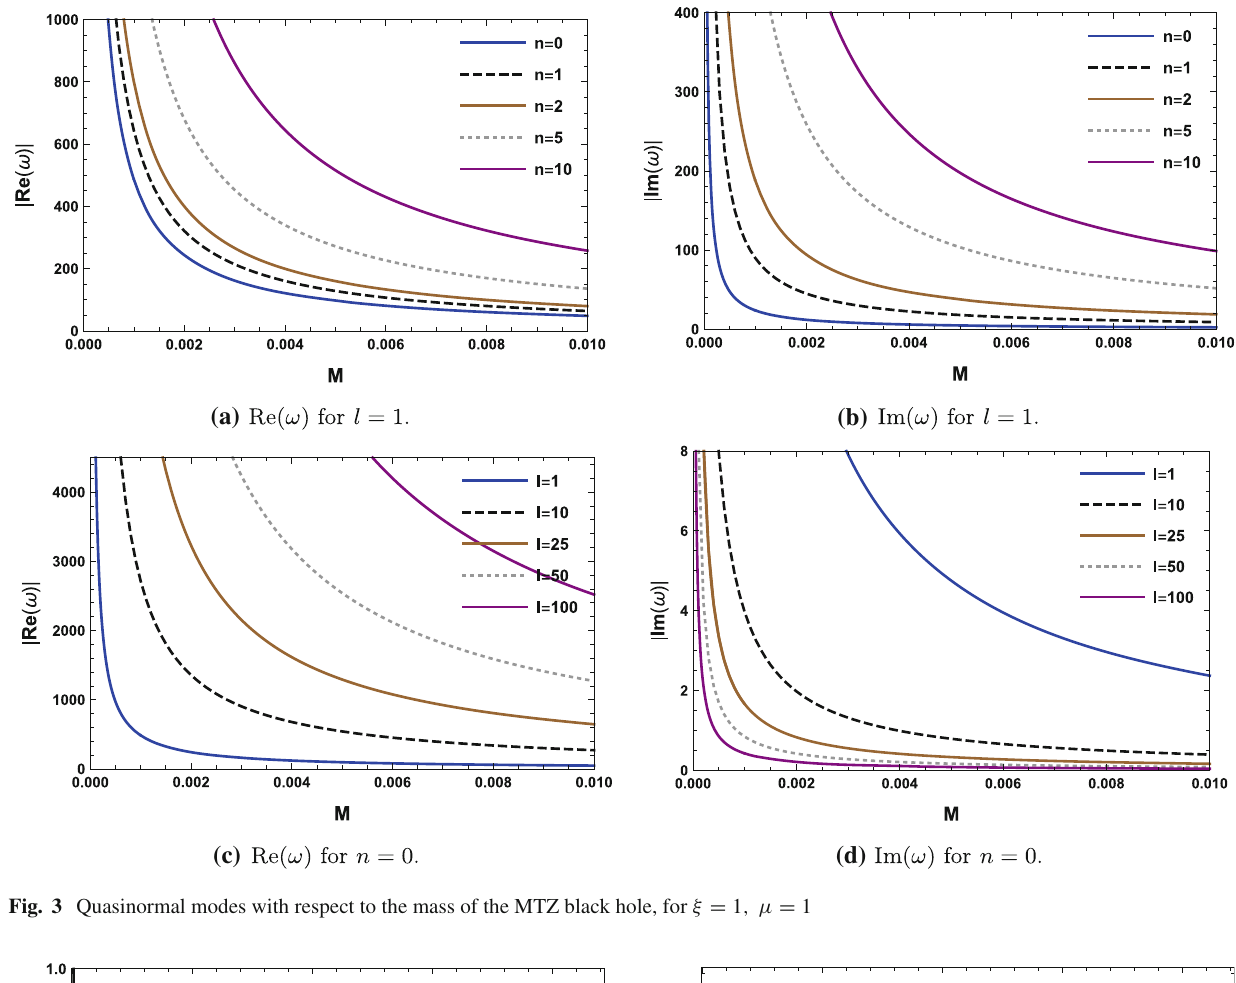
Fig. 3 Quasinormal modes with respect to the mass of the MTZ black hole, for ξ = 1 , μ = 1